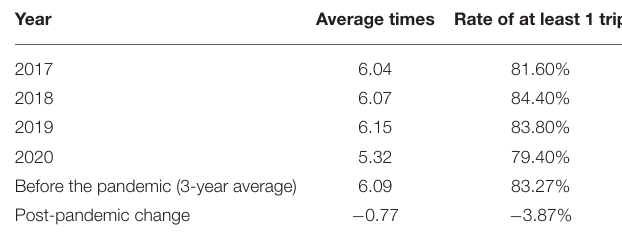
TABLE 2 | Frequency of